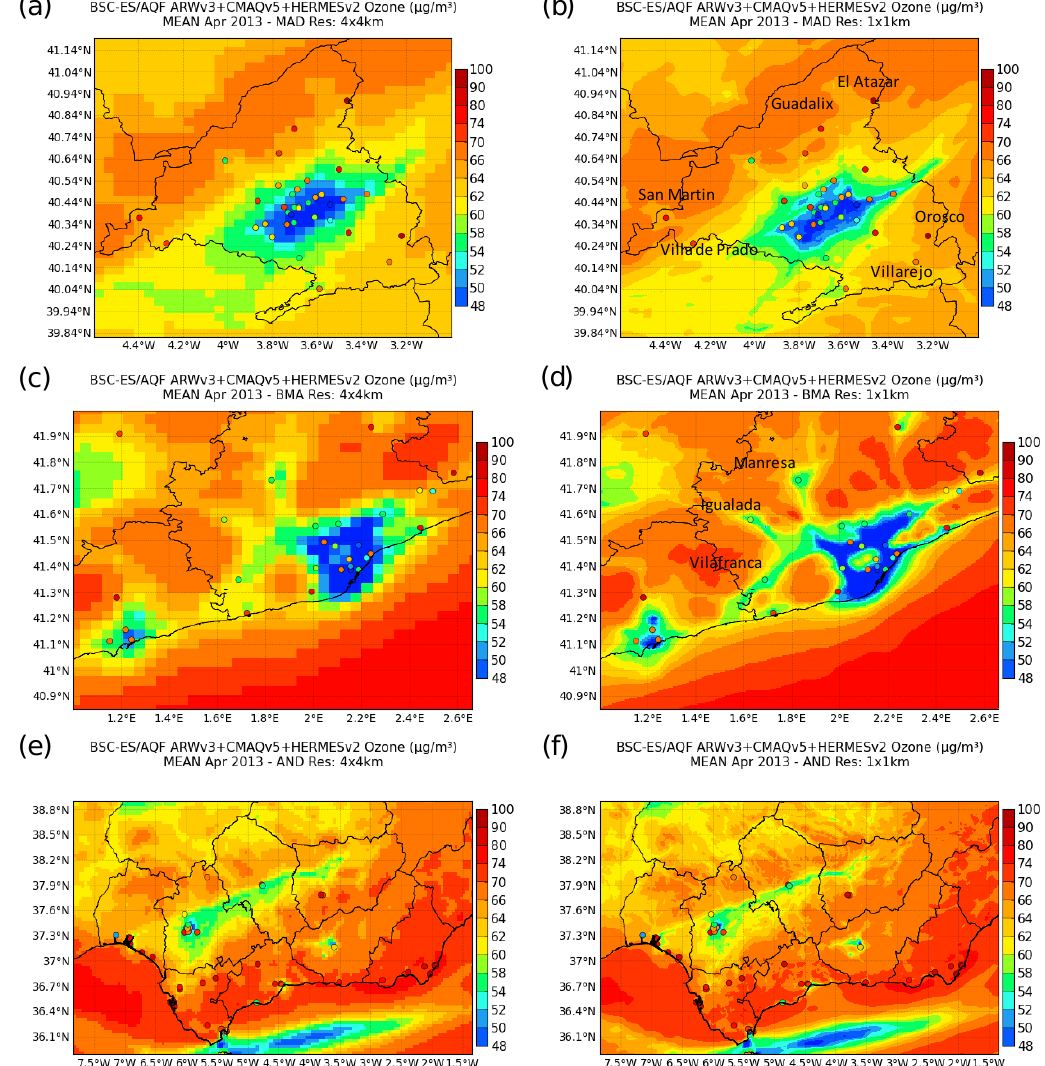
Figure 4. CALIOPE-AQFS mean O 3 concentrations (µgm − 3 ) in April 2013 over (a, b) MAD, (c, d) BCN, and (e, f) AND, as a function of horizontal resolution: 4km (left column) and 1km (right column). Dots indicate the mean concentrations at the air quality stations.